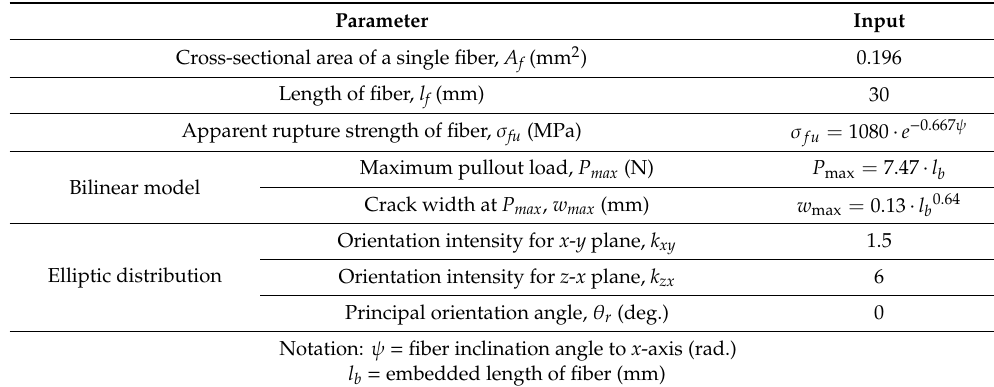
Table 4. Parameters for the calculation of the bridging